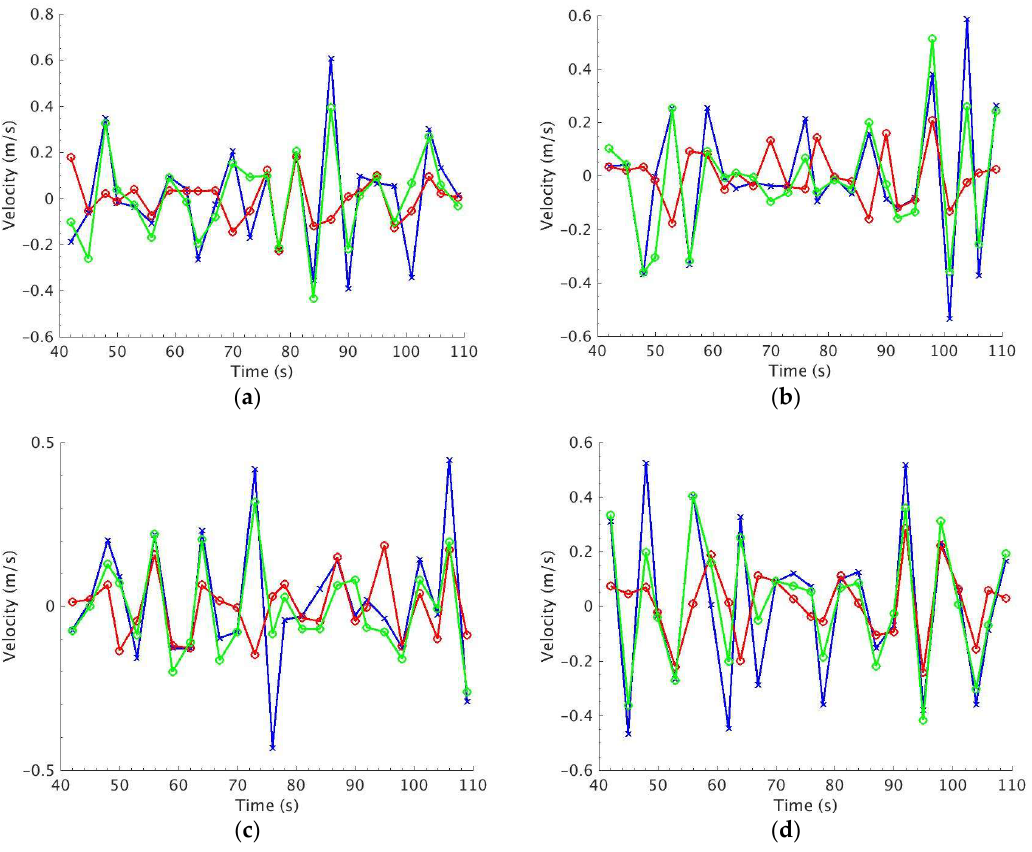
Figure 3. Time series comparisons between the GPS wave buoys (blue lines), POD reconstructions using the leading 32 modes ( n = 32) (green lines), and dispersion filtered reconstructions (red line) for dataset 1. ( a ) are the time series for wave buoy 279; ( b ) are the time series for wave buoy 283; ( c ) are the time series for buoy 286; and ( d ) are the time series for buoy 289.